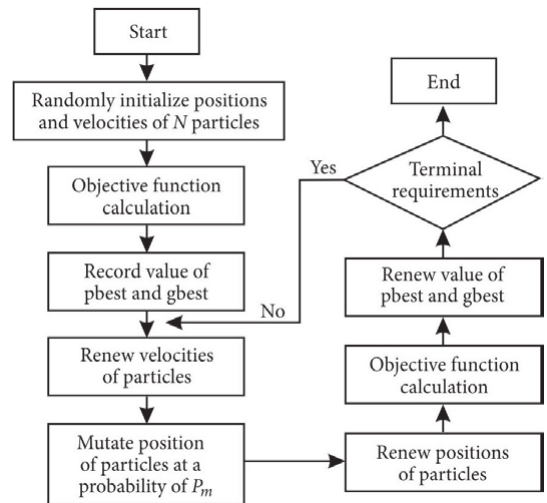
Fig. 2. Flow chat of Gaussian mutation particle swarm optimization